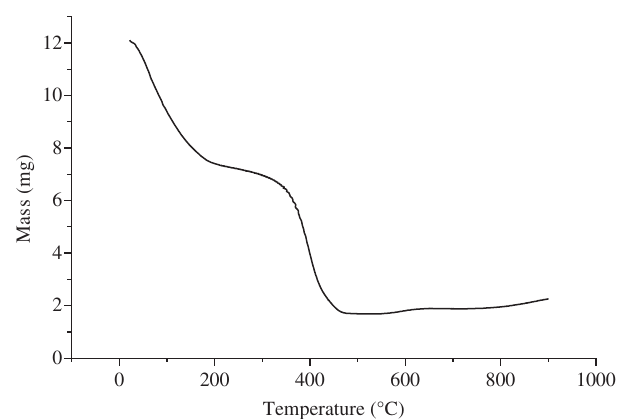
Figure 2. Mass change of the Al paint as a function of